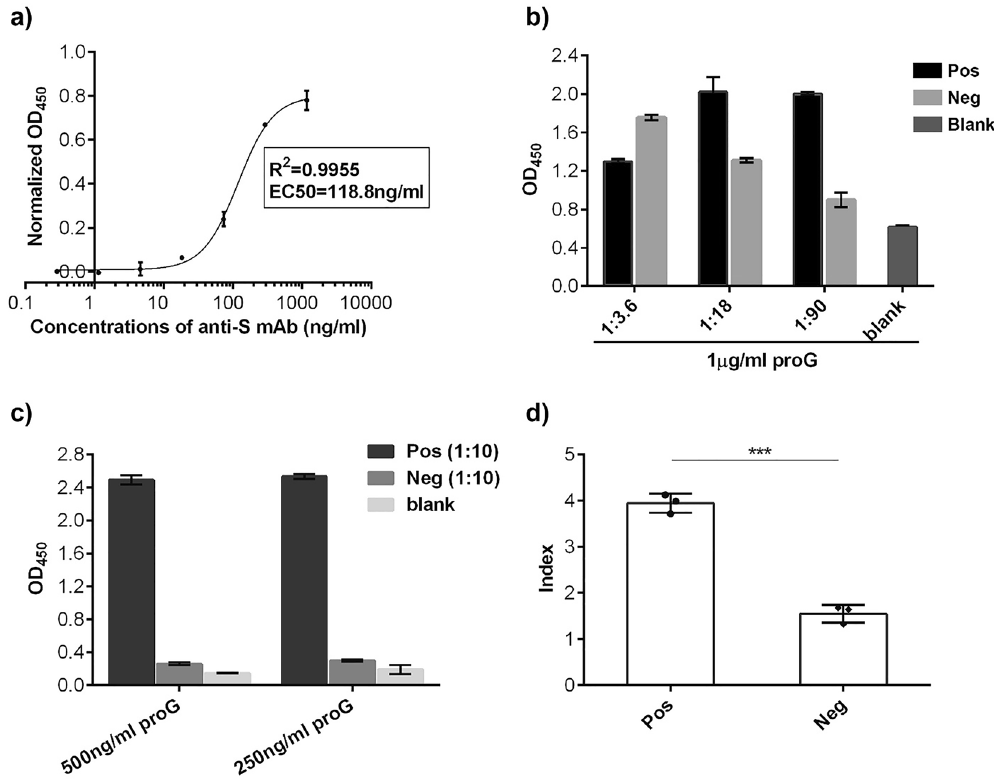
Figure 3. Verifying the assay specificity in detection of anti-SARS-CoV-2-S antibodies (IgG isotype) via ELISA. ( a ) The purified anti-SARS-CoV-2-S monoclonal antibodies (mAb) were detected in ELISA at various concentrations. ( b , c ) Anti-SARS-CoV-2-S antibodies (IgG isotype) in human serum samples were detected with serum diluted in ( b ) 1:3.6, 1:18 and 1:90 and in ( c ) 1:10. 1 µg/mL of -HRP protein G was used in ( b ) for detection while 500 ng/mL and 250 ng/mL were tested in ( c ). ( d ) Using the detection scheme for three positive serums and three negative serums could be significantly separated based on the index